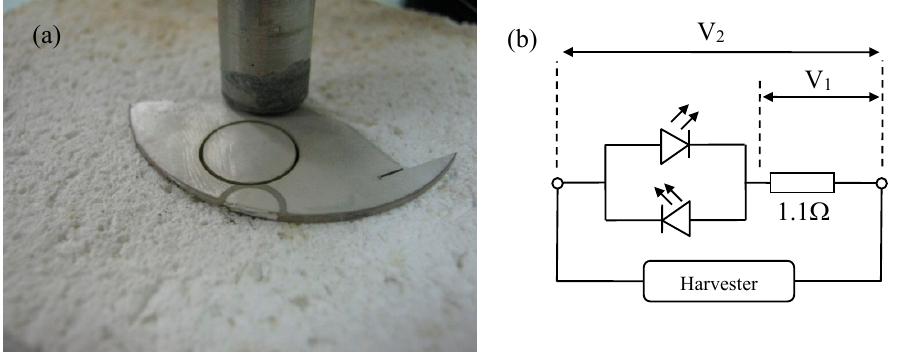
Figure 10. Setup to measure harvester properties under cutting conditions, ( a ) Cut ceramic disk; ( b ) LED circuit.